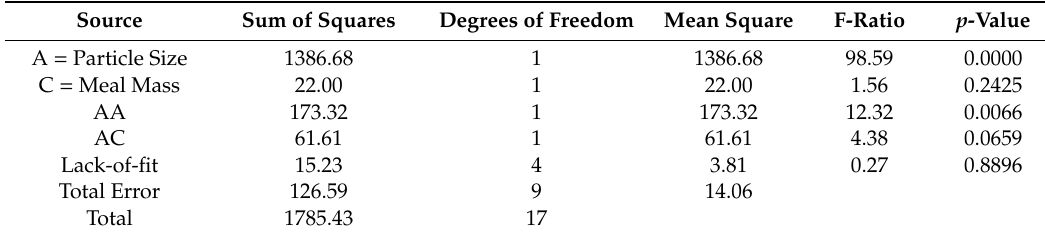
Table 6. ANOVA for the response surface experiment.